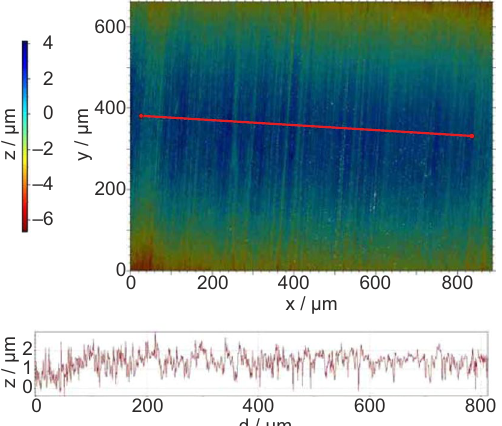
Figure 3. Characterization of the lateral surface of the sorption sinker using white light interferometry. Top panel: image from a white light interferometer with the relative heights depicted by the colour scale; the area imaged was the curved outer circumference of the sinker and, thus, the height falls off at the top and bottom of the image area. Bottom panel: relative height of the surface along the transect indicated by the red line in the top